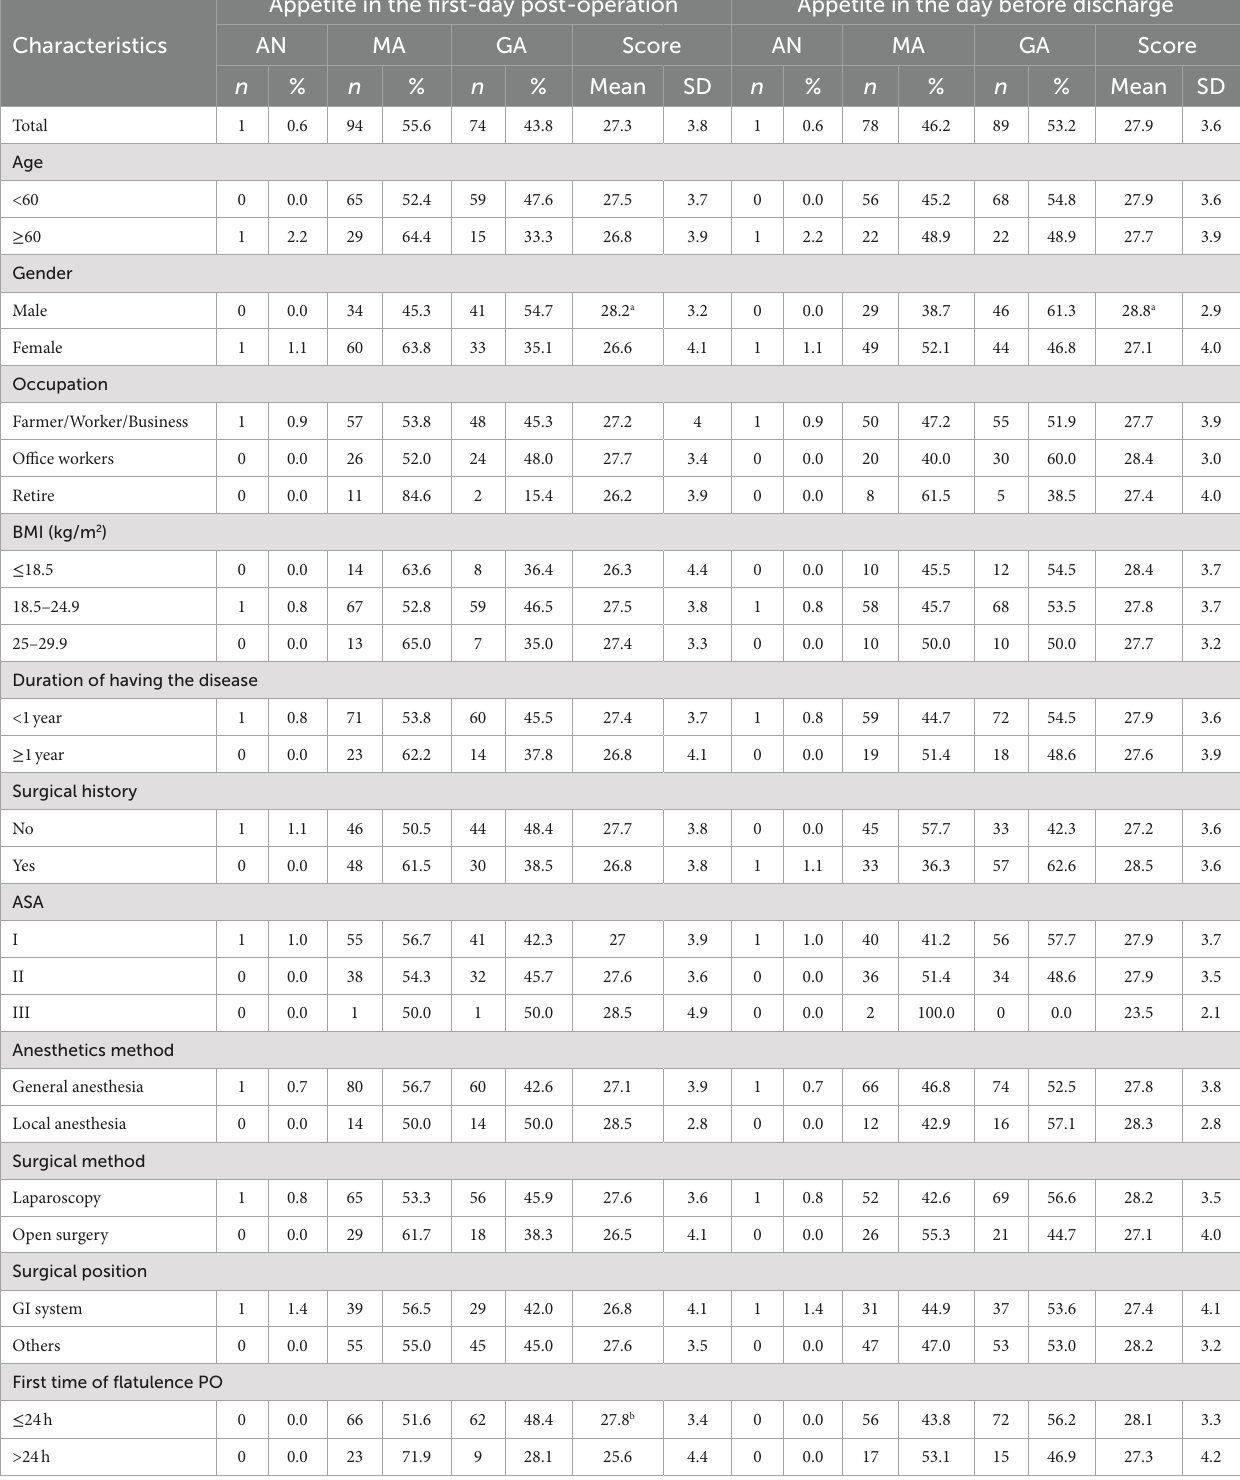
TABLE 3 Appetite status according to socioeconomic - and surgical - related